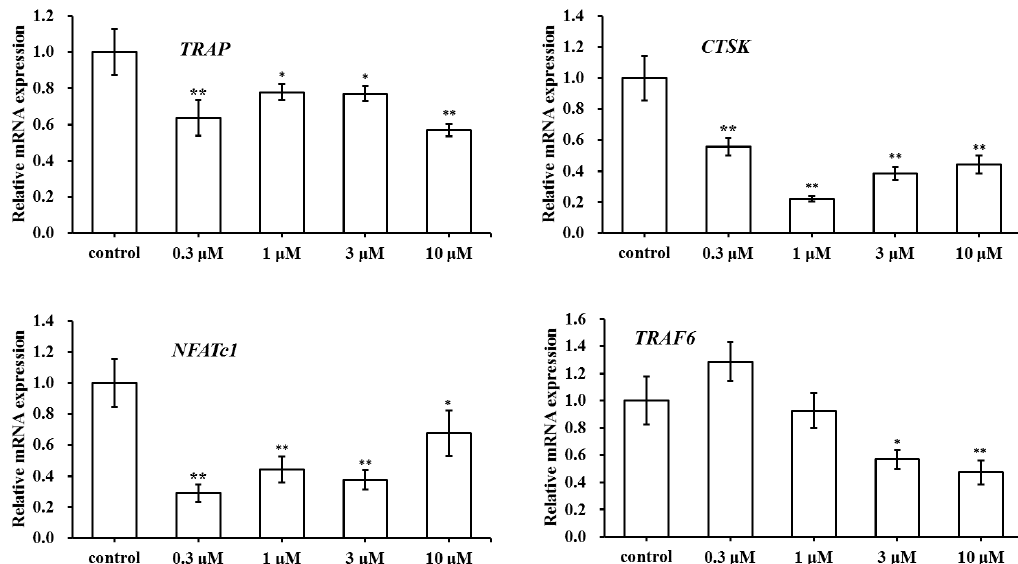
Figure 6. Effects of SC treatment on the relative mRNA expression levels of TRAP , Cathepsin K (CTSK) , NFATc1 , and TRAF6 . * p < 0.05, ** p < 0.01 compared with the control group.